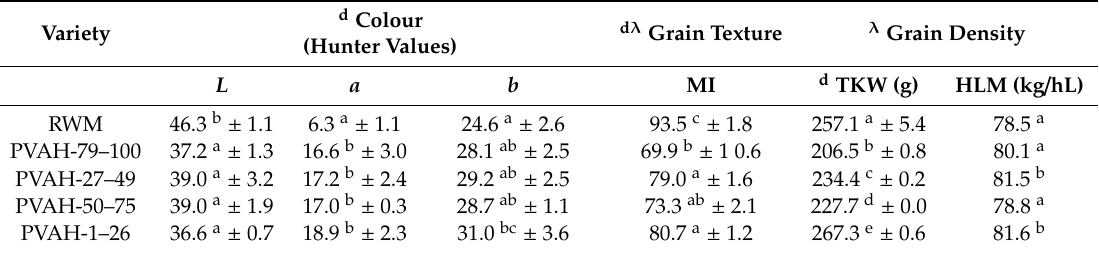
d λ Grain Texture λ Grain Density